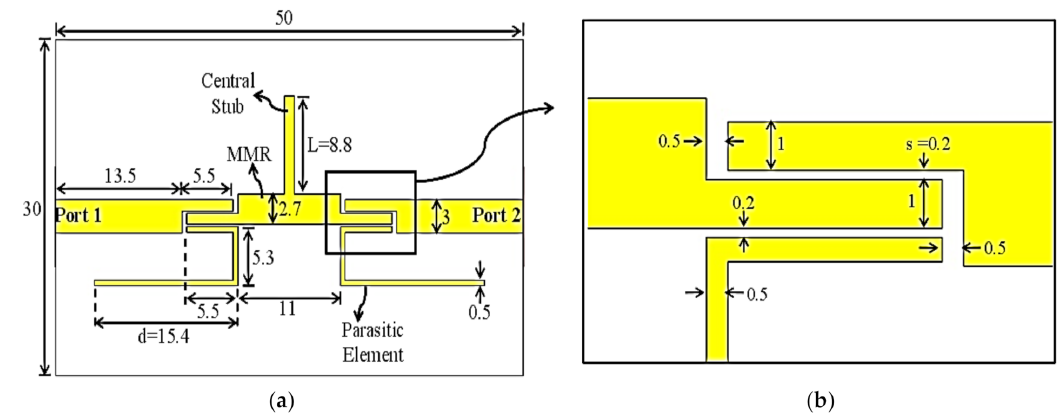
Figure 1. Geometry of the proposed filter: ( a ) dimensions of the overall structure and; ( b ) dimensions of the parallel line coupler (all dimensions are in